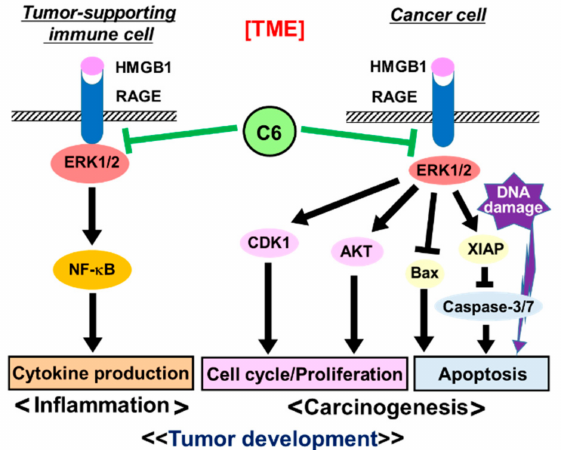
Figure 8. Schematic model for the anti-inflammatory and anti-proliferative effects of C6 on tumor- supporting immune cells and cancer cells, respectively, through the HMGB1-RAGE- signaling path- way in the TME. The potential mechanisms of the suppressive effects of C6 on cytokine production in tumor-supporting cells and cell cycle/proliferation and apoptosis in cancer cells via HNGB1- RAGE-ERK1/2 signaling pathway are shown. Additionally, the anti-cancer combination effects of C6 and DNA-damaging agents are illustrated. The interaction of HMGB1 with RAGE up-regulates the RAGE downstream signaling pathways. Consequently, RAGE-regulated genetic programs of pro-inflammation and carcinogenesis start driven by the action of various transcription factors, such as NF-kB and AP-1. C6 potently suppresses HMGB1-RAGE-ERK1/2 signaling and potentiates the anti-cancer effects of DNA-damaging agents on cancer